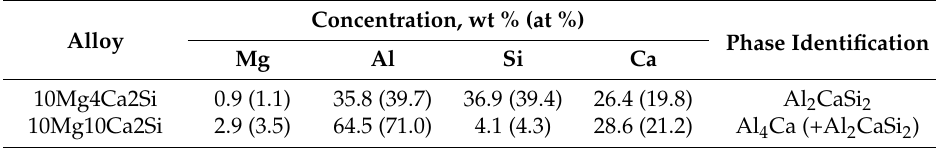
Table 5. Chemical composition of primary crystals in alloys Al10Mg10Ca2Si and Al10Mg4Ca2Si. Concentration, wt % (at %) Phase Alloy